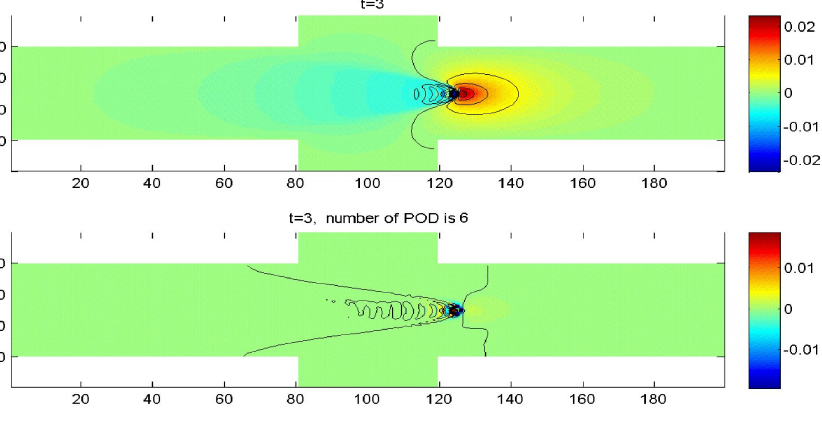
Figure 5. Top chart is the classical SCNMFE solution of pressure p and bottom chart is the POD-based reduced-order SCNMFE solution of pressure p with 6 POD bases when Re = 1000 and Pr = 7 at time t =